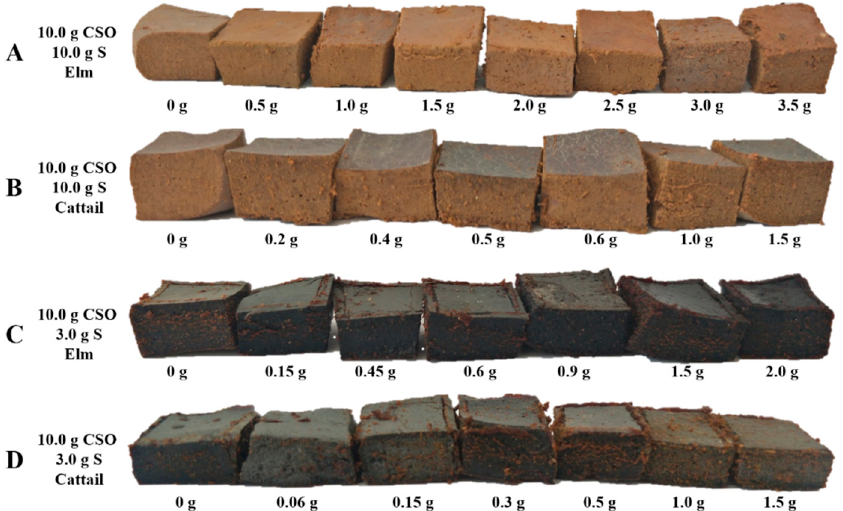
Figure 3. Picture of bio-based polysulfide composites prepared with different fillers. ( A ) 10.0 g CSO + 10.0 g S + elm, ( B ) 10.0 g CSO + 10.0 g S + cattail, ( C ) 10.0 g CSO + 3.0 g S + elm, ( D ) 10.0 g CSO + 3.0 g S + cattail.